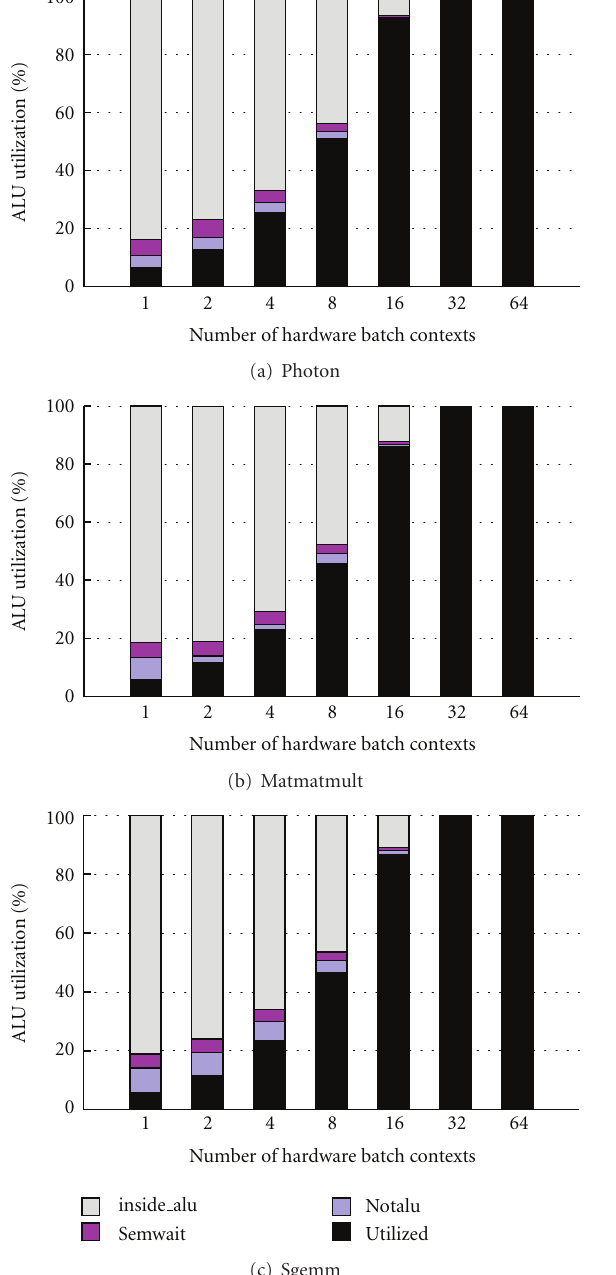
Figure 11: ALU datapath utilization for a 16-bit HT interface.